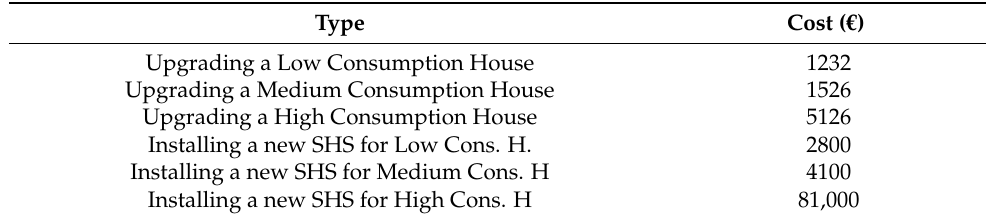
Table 2. Upgrading existing SHSs